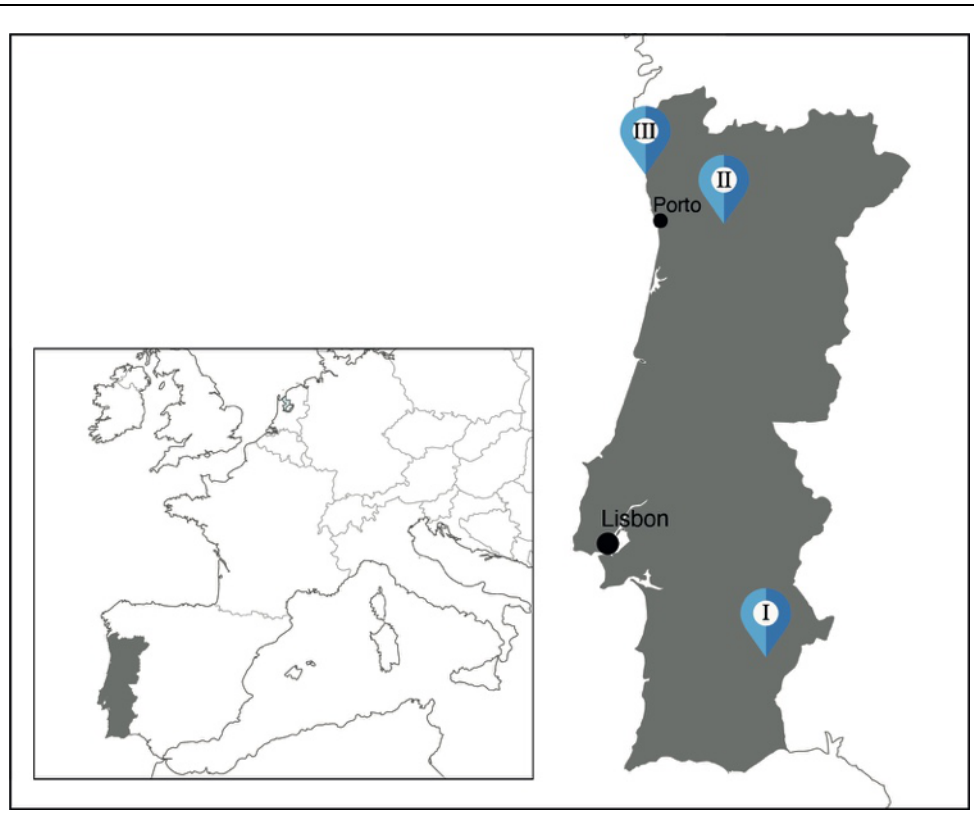
Figure 1. Giant reed harvest regions: Serpa (I), Santa Cruz do Douro (II) and Apúlia